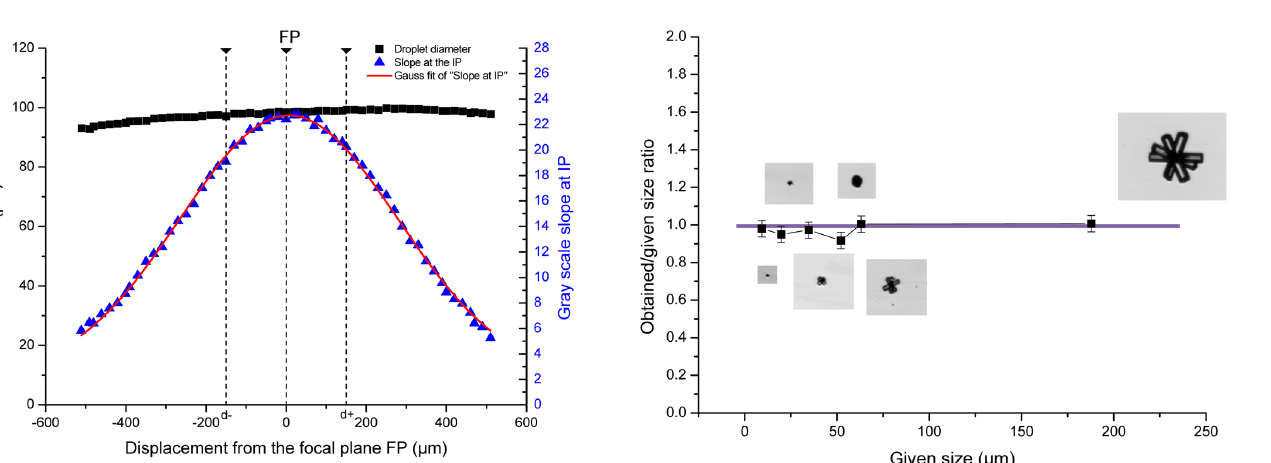
Fig. 6. The ratio of the evaluated particle sizes (using the devel- Figure 6. The ratio of the evaluated particle sizes (using the developed inflection point 3 oped inflection point algorithm) to those given as standard values algorithm) to those given as standard values for standard ice analogues. 4 for standard ice